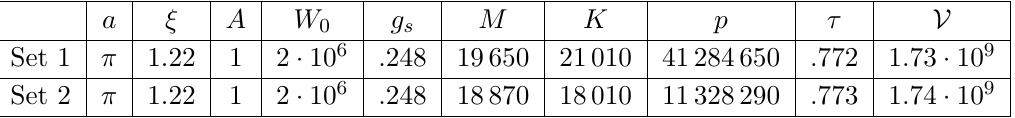
Table 5 . Two sets of parameters which give rise to two di(cid:11)erent in(cid:13)ationary regimes in KS.